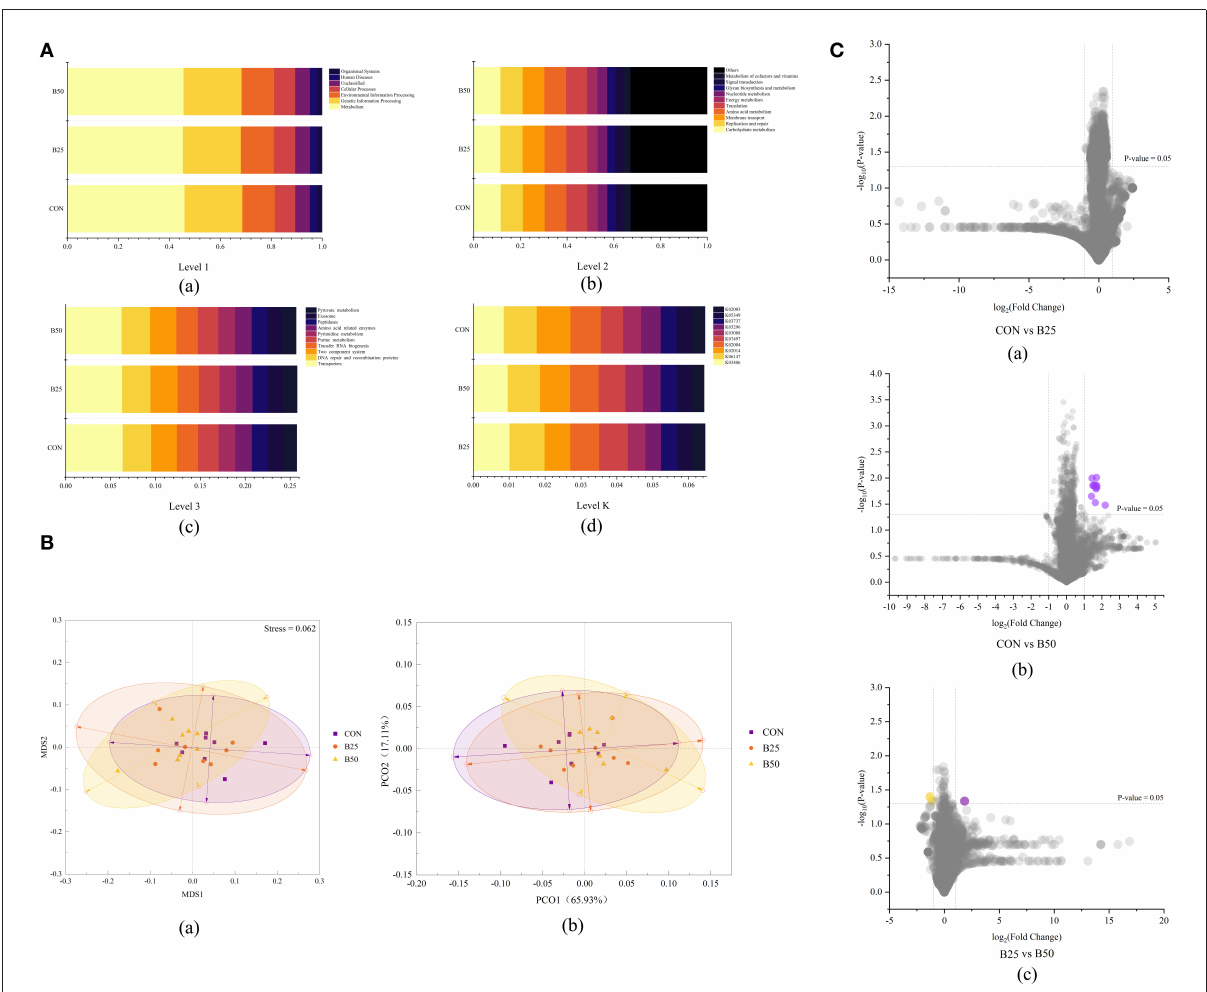
FIGURE7 Functional prediction on the composition and difference for fecal microflora in the three treatments. (A) Functional prediction on the fecal microflora: (a–d) bar plot of the relative abundance of the predicted function on levels 1, 2, 3, and K; (B) (a) NMDS plot; (b) PCoA plot; and (C) pairwise comparison of different functions between the groups based on the t